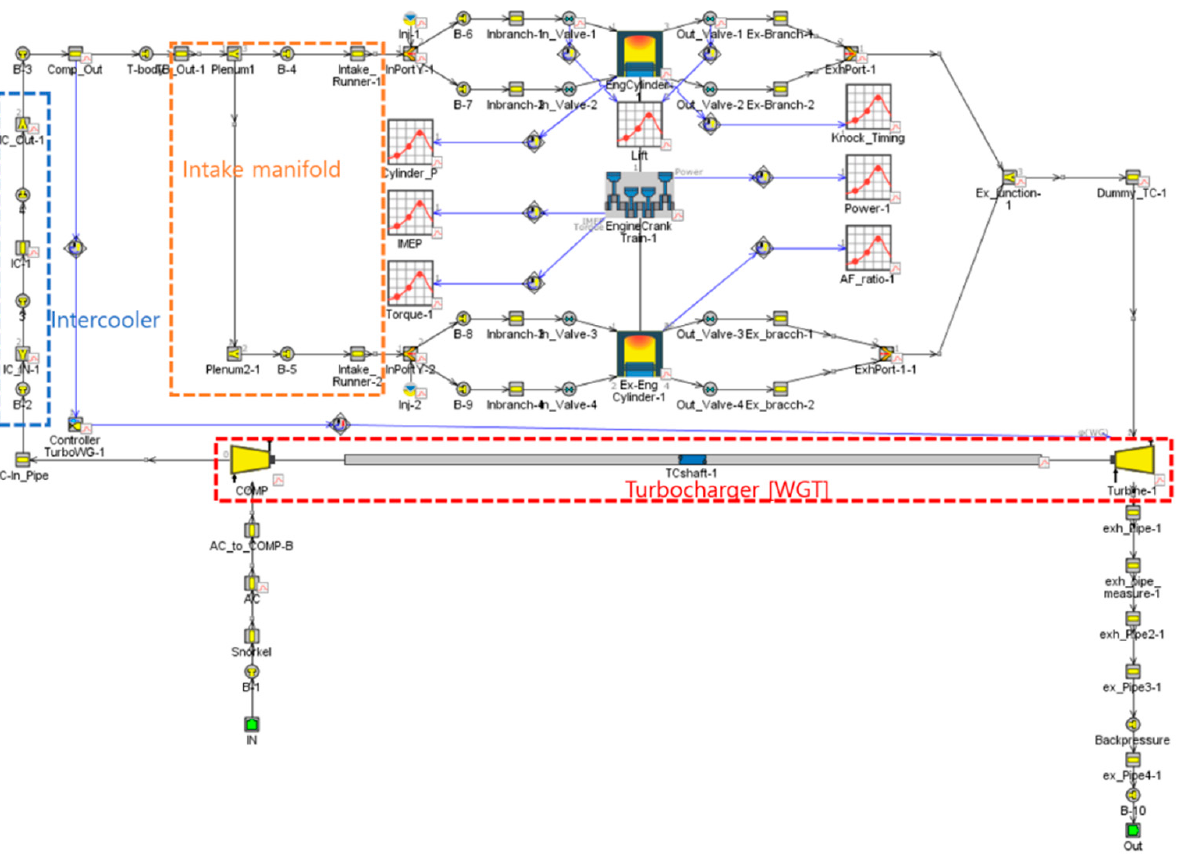
Figure 3. 1D-model